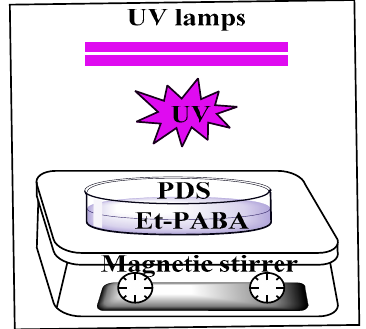
Figure 1. The apparatus used for the ethyl 4-aminobenzoate (Et-PABA) degradation.